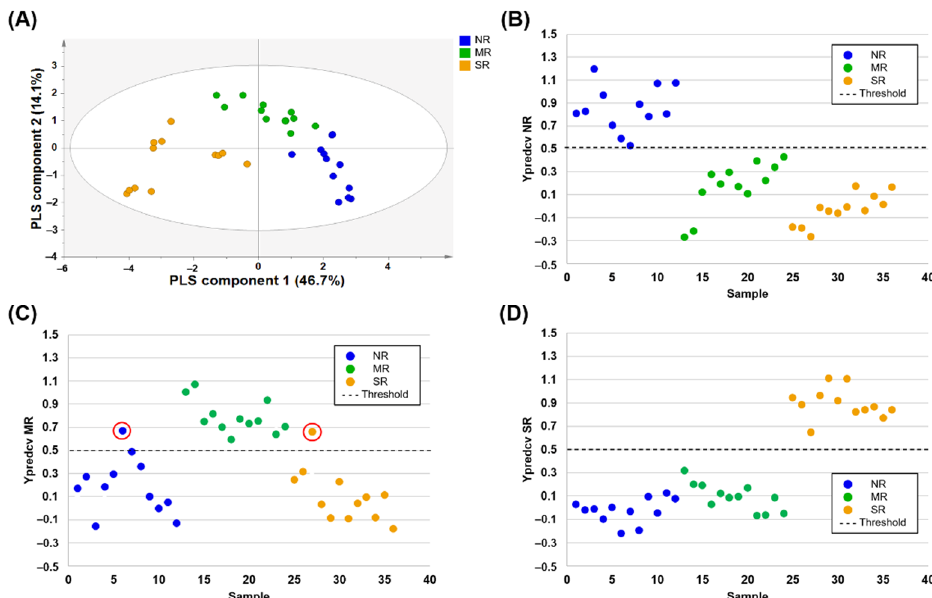
Figure 2. PLS-DA score plots ( A ) derived from the 1 H-NMR spectra of soybean samples for discriminating the geographical origin of three regions of China. Leave-one-out cross-validated score plots for NR vs. MR/SR comparative group ( B ), MR vs. NR/SR comparative group ( C ), and SR vs. NR/MR comparative group ( D ) showing control sample (one region, above dashed line) and case sample (two regions, below dashed line) with threshold value of 0.5 (dashed line) for all samples. In case of misclassified samples, the Ypredcv values were marked with red circles. NR: northeastern region, MR: middle region (Huang-Huai-Hai and Yangtze River region), SR: southern